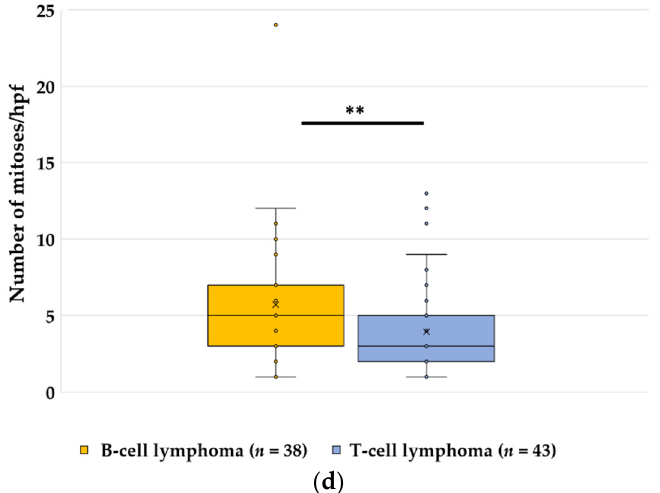
Figure 4. ( a ) Cell size of lymphomas in the stomach, small intestine and large intestine ( n = 472). The cell size of lymphomas in the stomach and the small intestine (***, p < 0.001), as well as the small and the large intestine (***, p < 0.001), varied significantly. Small-cell lymphomas were frequently detected in the small intestine and absent in the large intestine. (NOS and lymphomas in more than one sample are not included in the graph.) ( b ) Distribution of feline lymphomas of varying cell sizes and their number of mitotic figures/hpf in feline lymphomas ( n = 452) in different sites of the gastrointestinal tract. In the small intestine, the number of mitoses was significantly lower in small-cell lymphomas than in medium-sized (***, p < 0.001) and large-cell (***, p < 0.001) lymphomas. The wide range of mitotic numbers in all cell sizes of the alimentary lymphomas was noteworthy (intestine NOS and lymphomas in more than one sample are not included in the graph). ( c ) The distribution of feline lymphomas of varying cell sizes and immunophenotypes ( n = 79) in different sites of the gastrointestinal tract shows that B-cell lymphomas were most common in the stomach and the large intestine, while T-cell lymphomas were most common in the small intestine. (NOS and lymphomas in more than one sample are not included in the graph.) ( d ) The number of mitotic figures/hpf was significantly higher in feline B-cell than in T-cell lymphomas (**, p = 0.008).